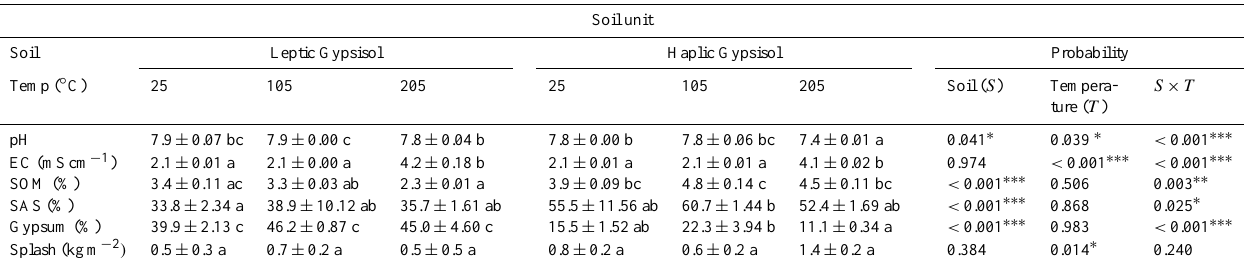
Table 1. Mean value, standard deviation, mean comparison and their probability (ANOVA) according to the soils ( S ), temperature ( T ) and both ( S × T ), of the studied variable. ( ∗∗∗ ) p < 0 . 001; ( ∗∗ ) p < 0 . 01; ( ∗ ) p < 0 . 1. For each soil property (line), different letters (a, b, c) show significant differences ( P < 0 . 05) among means, by post hoc Tukey